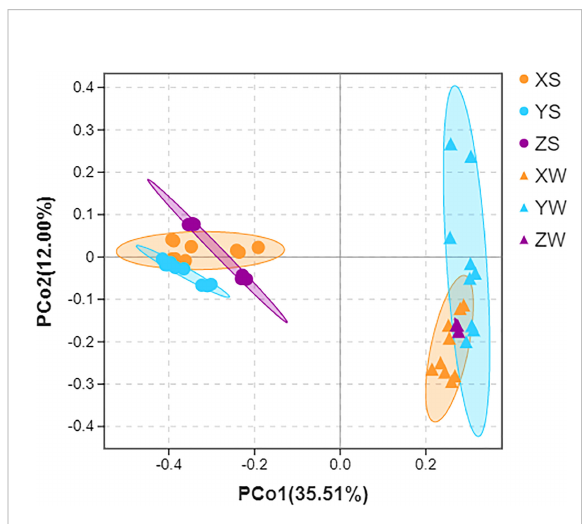
FIGURE 6 Principal coordinate analysis (PCoA) of Jaccard dissimilarity in water and sediment samples. X, Y, and Z indicate the fi ngerling, rearing, and harvesting stages, respectively, and S and W indicate the pond water and sediment samples,